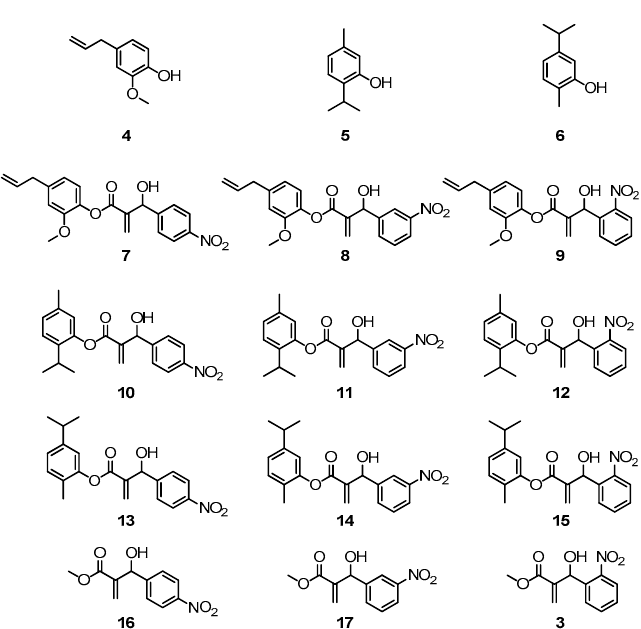
Figure 1. The MBHA hybrids synthetized, biologically evaluated and conformationally studied in